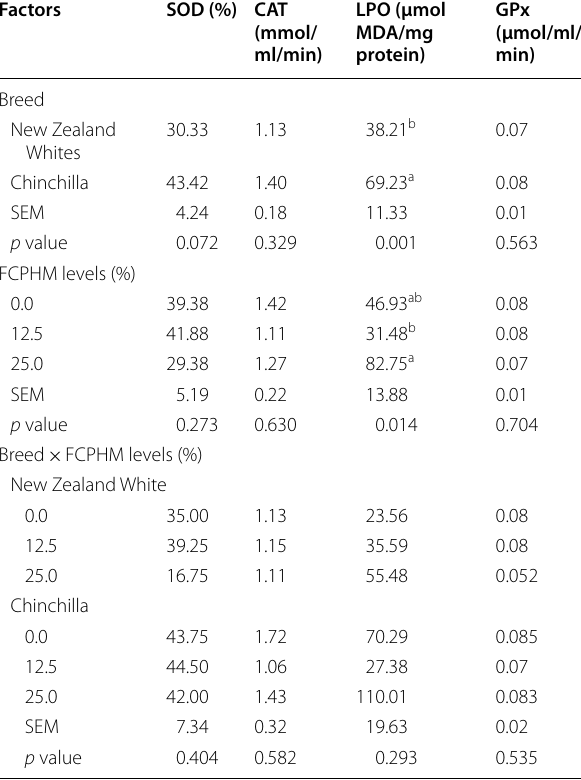
Table 7 Serum antioxidant profile of New Zealand White and Chinchilla rabbits fed diets containing varied levels of fermented cocoa pod husk